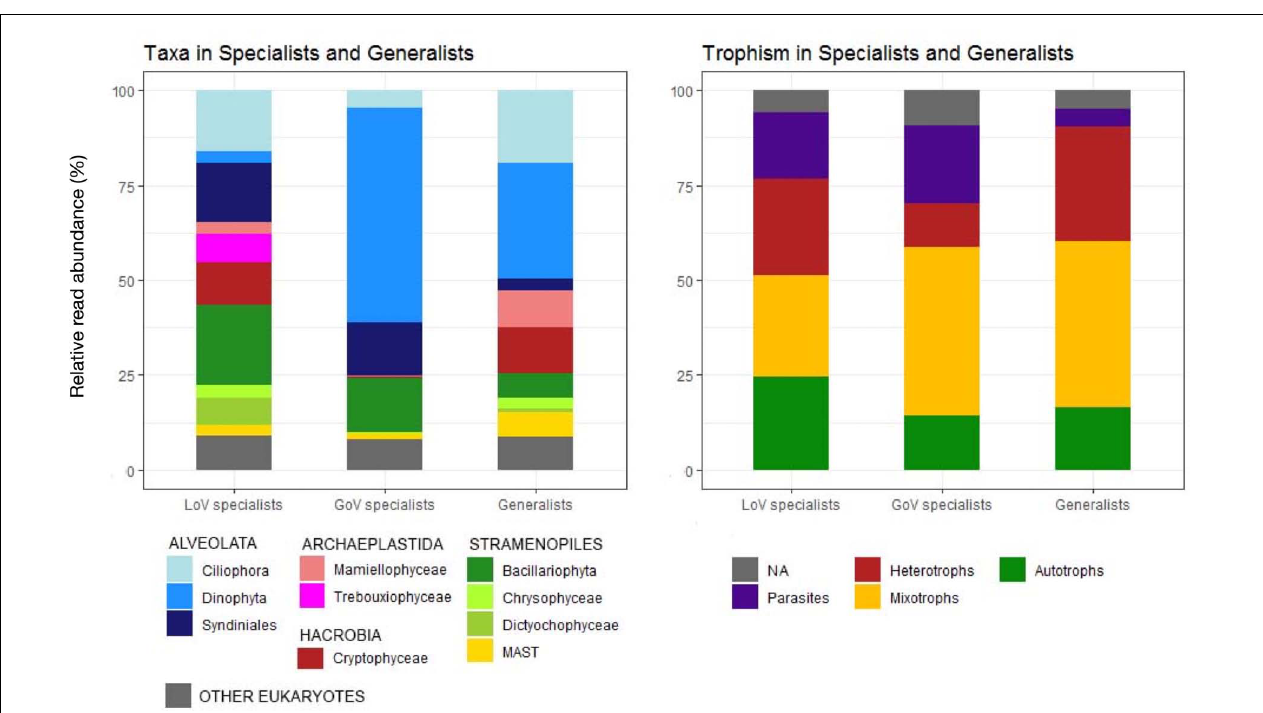
FIGURE 5 | Canonical Correspondence Analysis (CCA) based on the normalized dataset. Biplot of environmental parameters: (A) Lagoon of Venice (LoV) community ( p < 0.01), (B) Gulf of Venice (GoV) community ( p < 0.05). Sal, salinity; Temp, temperature; DIN, Dissolved Inorganic Nitrogen; P-PO 4 , orthophosphates; Chl a , chlorophyll a .